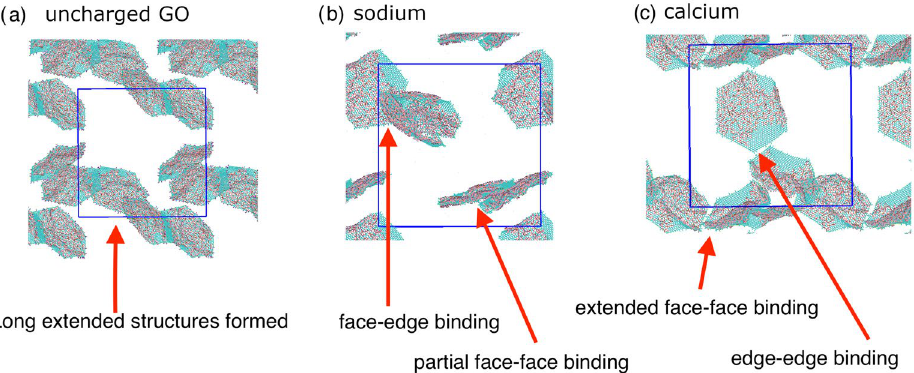
Figure 4. Snapshots from the atomistic simulations at 300K after the simulated annealing run, illustrating the different binding modes observed for GO with a C:O ratio of 2.5. The same binding modes are observed in the CG simulations. ( a ) For uncharged graphene oxide with protonated carboxylic acid groups, a long extended structure is formed, with aggregation over both the graphitic carbons and the oxidised regions. ( b ) For deprotonated carboxylic acid groups and sodium counterions, the GO sheets are more dispersed, but we still observe face-face binding and face–edge binding. ( c ) For deprotonated carboxylic acid groups and divalent calcium ions, we find face-face binding modes, along with edge–edge binding with Ca 2 + acting as an ion bridge. Water and counterions have been removed to aid visualisation. The blue lines are the periodic boundaries; we have shown atoms in the periodic replicas to better illustrate the extended structures